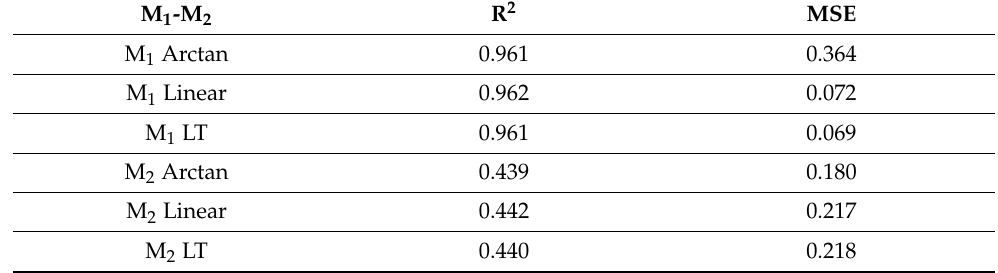
Table 2. Determination coefficient: R 2 , and MSE (mean square error) for M 1 and M 2 simulated values.